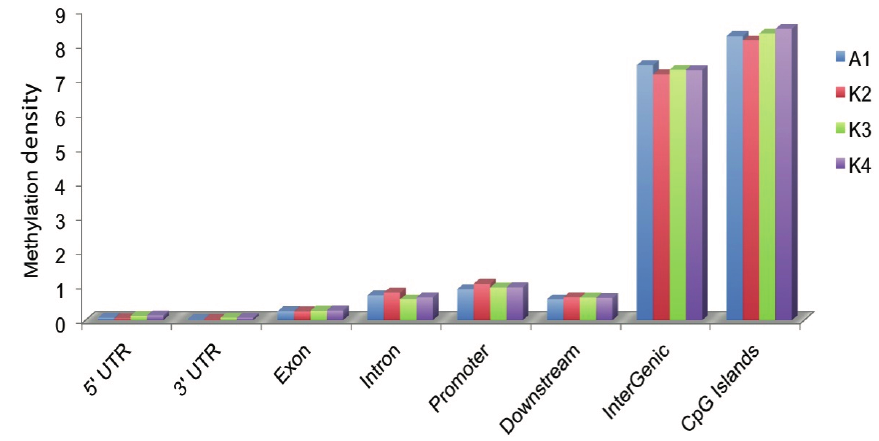
Figure 2. Methylation distributions in different genomic regions. Methylation density within promoter, gene body and intergenic regions was calculated with the ratio of methylated peaks in a particular component to the total area of that